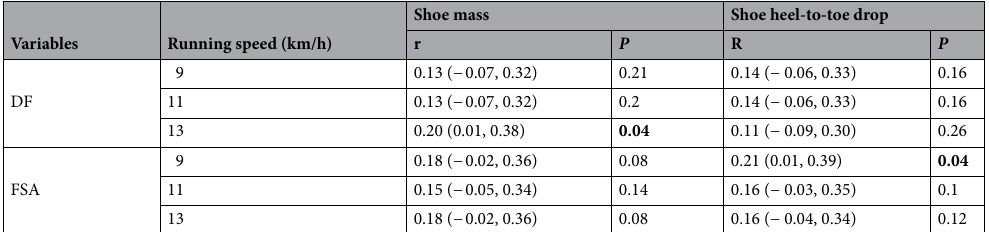
Table 4. Pearson’s correlation coefficients ( r ) and the corresponding 95% confidence intervals (lower, upper) and P -values for the relationships among shoe mass, shoe heel-to-toe drop, foot-strike angle (FSA), and duty factor (DF) for three tested speeds. The statistically significant correlations ( P ≤ 0.05) are indicated in bold font.